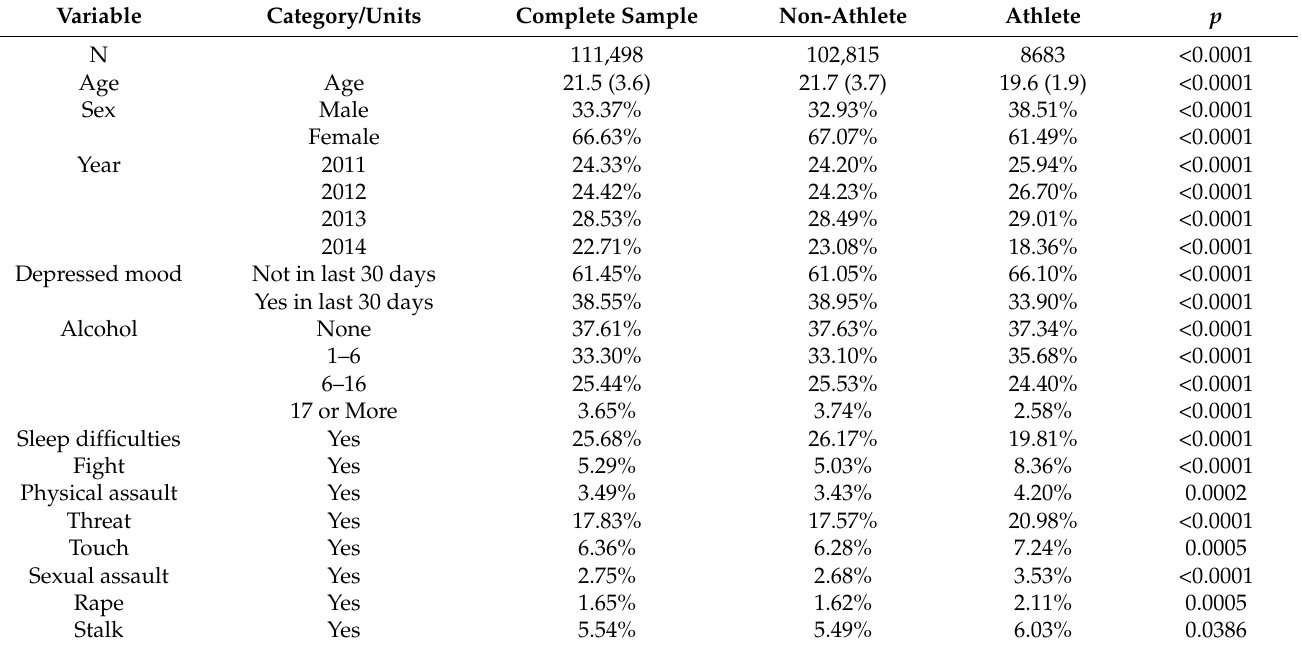
Table 1. Characteristics of the